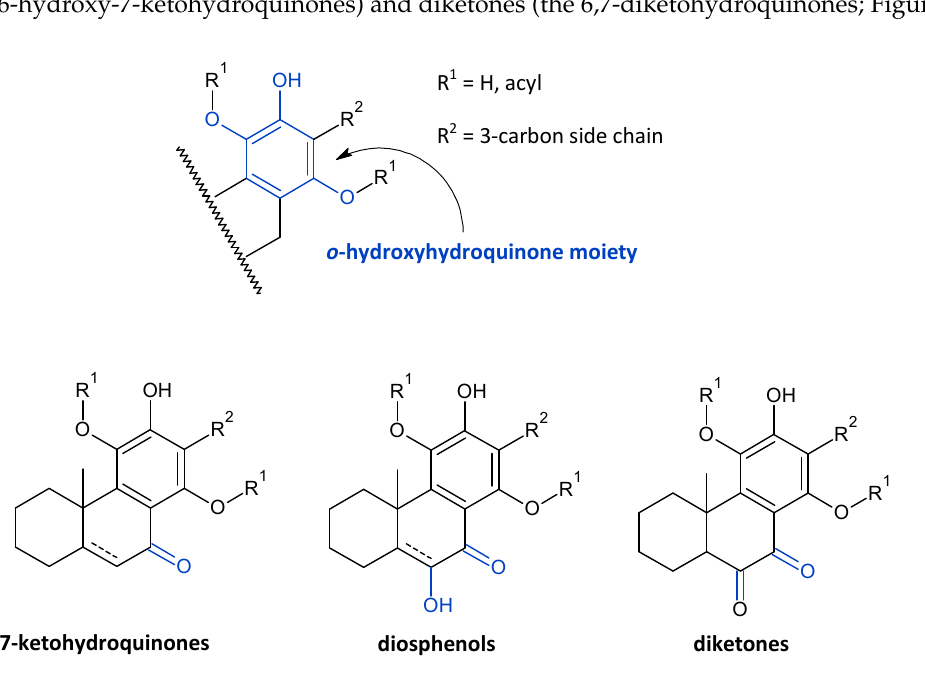
Figure 7. Hydroquinone skeleton and the substitution of the B ring. Hydroquinones are the largest group of abietanes with an aromatic ring C,